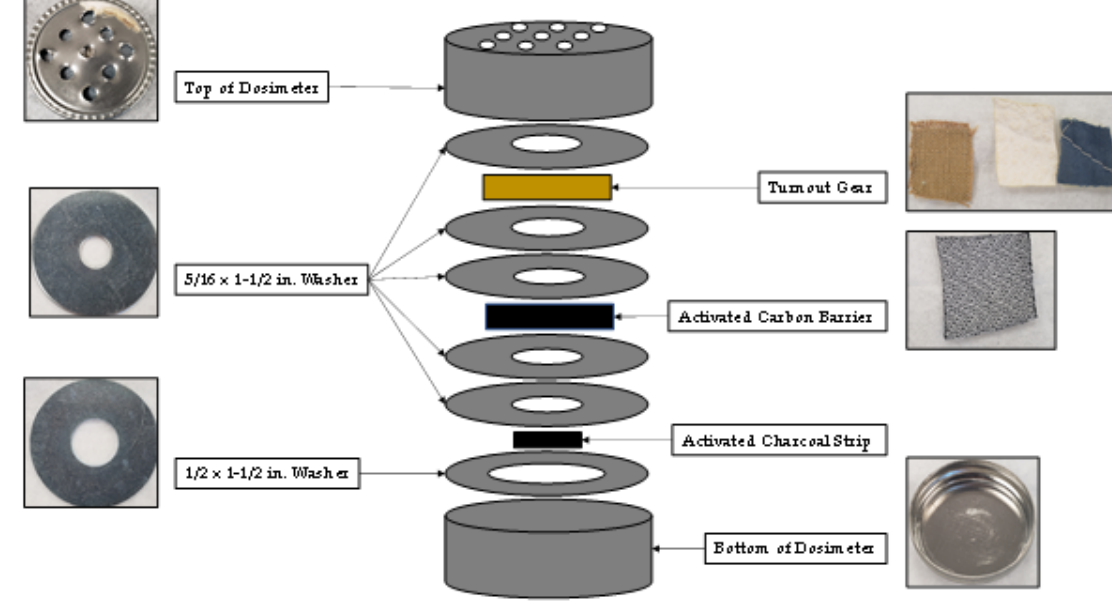
Figure 1. Diagram of passive sampling dosimeter containing turnout gear, ACL, and activated charcoal strip.